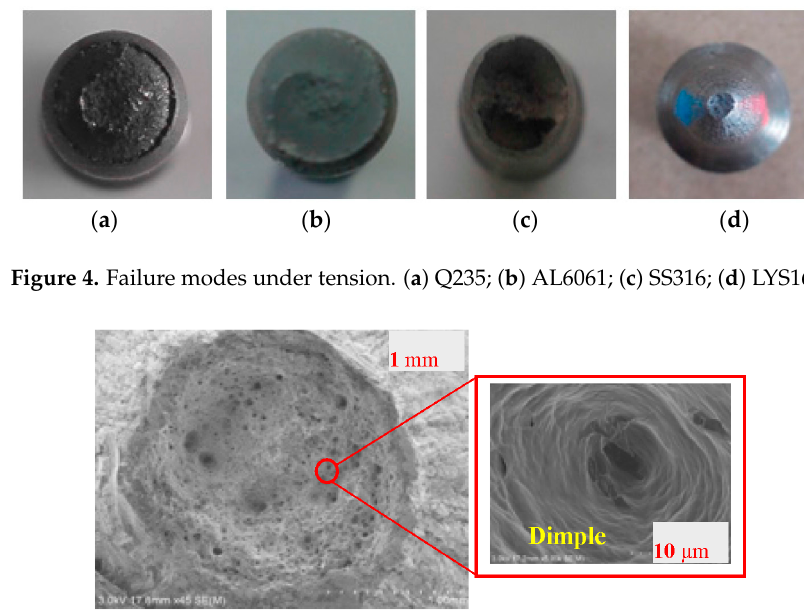
Figure 5. Fracture section of LYS160.